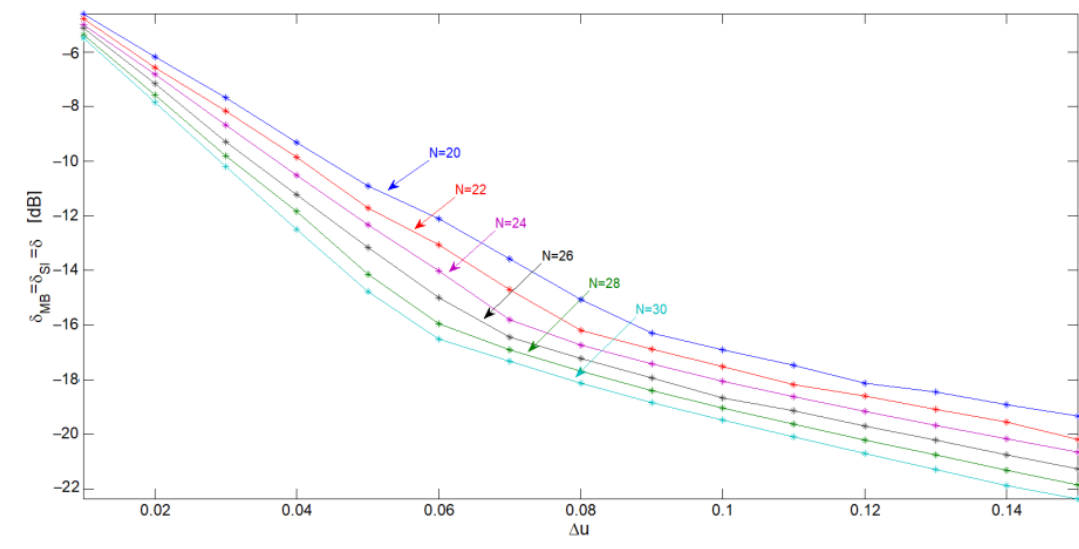
Figure 2. Case of equality between the main beam width and the side lobe region width, and K des = δ MB / δ SL = 1: the curves show δ = ( δ MB = δ SL ) as a function of ∆ u for N taking values from 20 to 30 .